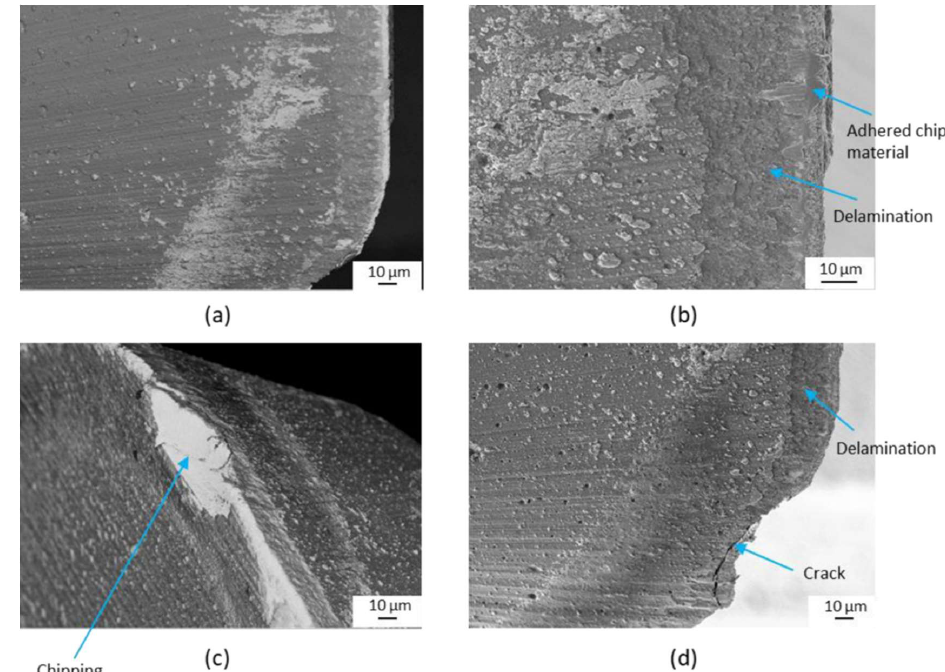
Figure 8. Tool wear mechanisms when machining wrought Ti-6Al-4V alloy: ( a ) SEM micrographs of the cutting tool after a cutting length of 500 m; ( b ) built-up layer of titanium material and coating delamination; ( c , d ) fractures and chipping of the cutting edge [121] (Reprinted with permission from [121]. Copyright 2020, Elsevier).